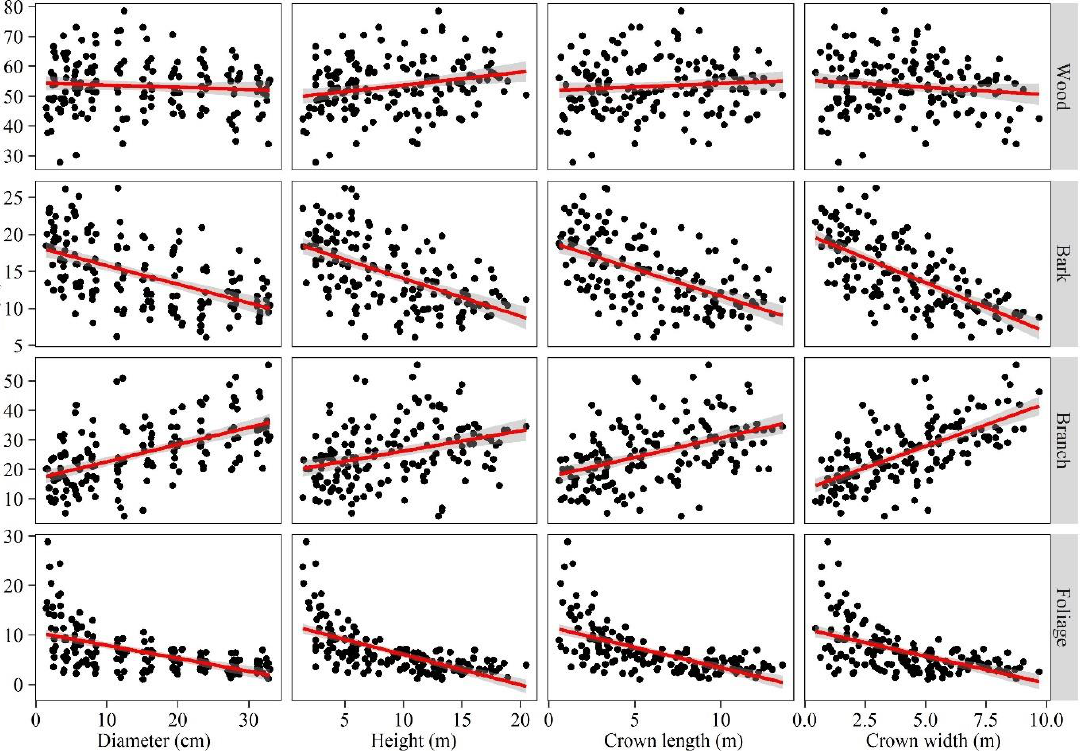
Figure 3. The fraction of aboveground biomass allocated to the wood, bark, branches and foliage varied with diameter, height, crown length and crown width. Red solid lines and grey areas are loess smoothing with 95% confidence intervals.